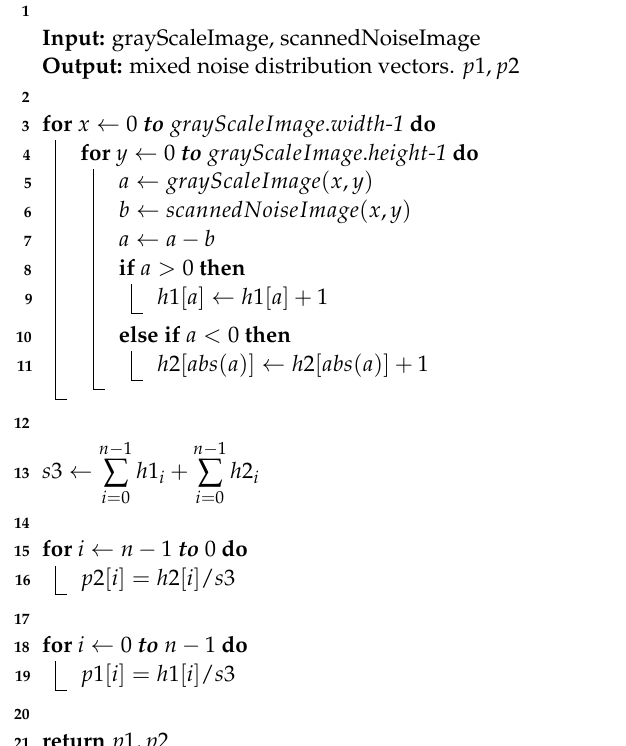
Algorithm 5 Algorithm that obtains the probability distribution of the acquisi- tion noise.